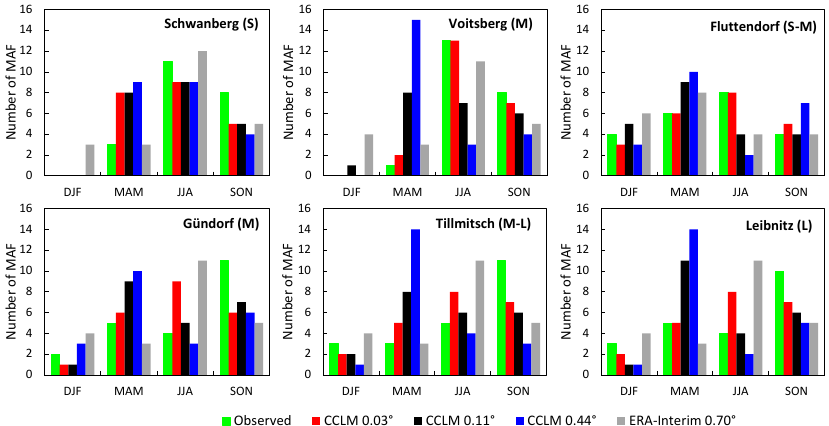
Figure 8. Number of maximum annual floods in the four seasons (seasonality) from the simulation using raw CCLM data as input compared to the observation at the selected gauges in the period